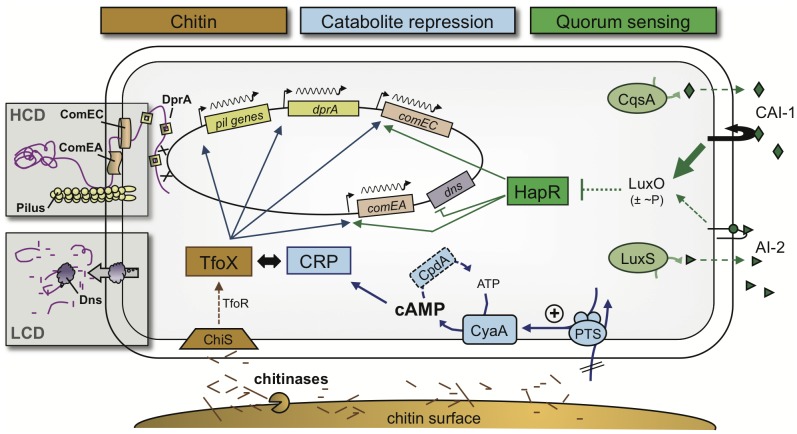
Model of the regulatory network of natural competence and transformation of V. cholerae.At least three extracellular and intracellular signaling molecules must be present to allow natural transformation to occur in V. cholerae. 1) Chitin degradation products such as chitin oligomers, which lead to the induction of the sRNA TfoR and the main regulator of transformation TfoX (chitin pathway shown in brown). 2) The secondary messenger cAMP, which has to accumulate within cells (CCR pathway shown in blue). 3) Extracellular autoinducers, with an emphasis on the stronger autoinducer CAI-1, which feed into the quorum-sensing circuit (shown in green). Whereas chitin- and TfoX-dependent induction and the requirement for cAMP and CRP are universal for all, so far investigated, competence genes, the QS-dependent circuit regulates only a subset of those, such as comEA and comEC. Therefore, QS acts as a switch in gene expression and is responsible for the final fate of the surrounding DNA (boxed areas). At a low cell density (LCD), the DNA (shown in purple) is degraded by the nuclease Dns. As a consequence, the cells are non-transformable. At a high cell density (HCD) and, therefore, high abundance of the autoinducer CAI-1, the nuclease gene dns is transcriptionally repressed, whereas comEA and comEC are activated. ComEA as well as ComEC then contribute to the DNA uptake process, probably due to their ability to shuffle the DNA through the periplasmic space and the inner membrane, respectively.